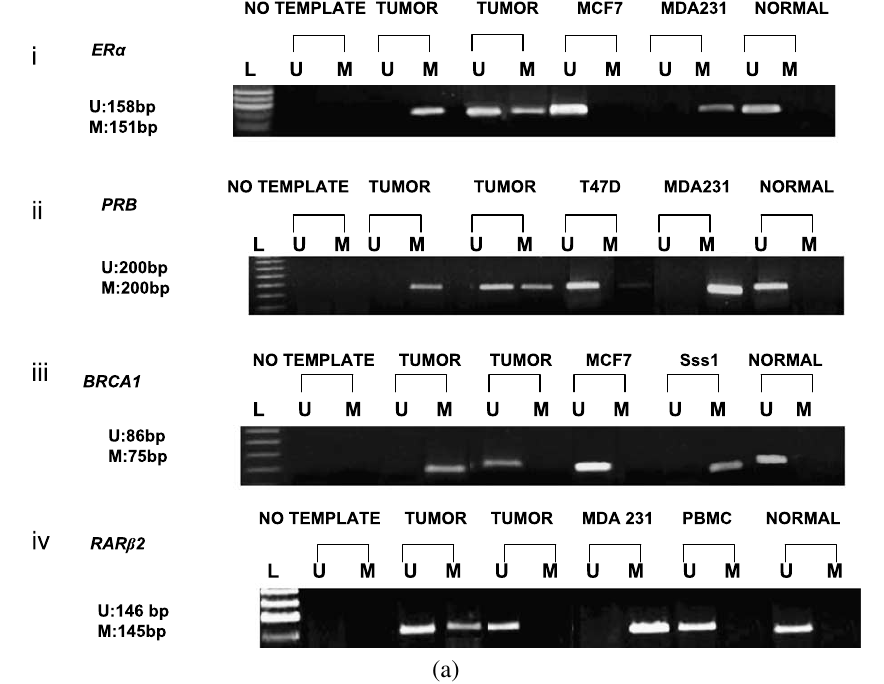
Fig. 1. (a) MSP analysis of ER α , PRB , BRCA1 and RAR β 2 genes in archival breast tumors. (i) ER α panel viewed from left to right shows a 50-bp ladder as molecular weight marker, a water control for contamination in the PCR reaction, patient 1 shows presence of methylated DNA in tumor, patient 2 shows presence of both methylated and unmethylated DNA. Breast cancer cell line MDA-231 used as a positive control shows methylated DNA. MCF-7 used as a positive control for unmethylated DNA, normal breast tissue used also shows unmethylated DNA. (ii) PRB panel viewed from left to right shows a 50-bp ladder as molecular weight marker, a water control for contamination in the PCR reaction, patient 1 methylated DNA is detected in tumor, patient 2 shows presence of both methylated and unmethylated DNA. Breast cancer cell line MDA-231 used as a positive control shows methylated DNA. T47D used as a positive control for unmethylated DNA, normal breast tissue used also shows unmethylated DNA. (iii) BRCA1 panel viewed from left to right shows a 50-bp ladder as molecular weight marker, a water control for contamination in the PCR reaction, patient 1 methylated DNA is detected in tumor, patient 2 shows presence of unmethylated DNA in tumor. Breast cancer cell line MCF7 used as a positive control shows unmethylated DNA whereas Sss1 treated PBMC cells were used as a positive control for methylated DNA, normal breast tissue used also shows unmethylated DNA. (iv) RAR β 2 panel viewed from left to right shows a 50-bp ladder as molecular weight marker, a water control for contamination in the PCR reaction, patient 1 shows presence of methylated and unmethylated DNA in tumor, patient 2 shows presence of unmethylated DNA detected in tumor. PBMC used as a positive control shows unmethylated DNA.MDA-231 used as a positive control for methylated DNA, normal breast tissue also shows unmethylated